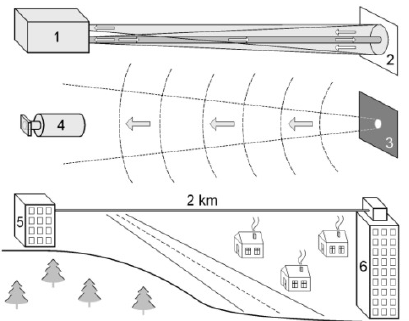
Fig. 2. Schematic of the experiment: lidar 1 and topographic target 2 (top), image jitter sensor: diffuse luminous white disk 3 on black and teleobjective with CCD camera 4 (center), probing path between buildings 5 and 6, and rough site plan